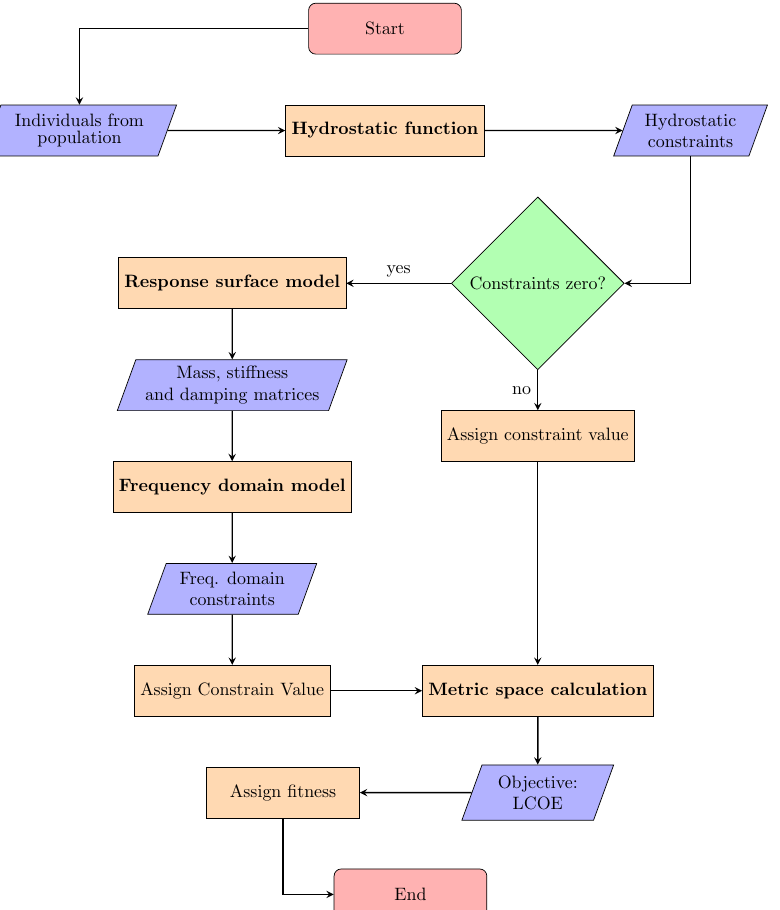
Figure 5. Flowchart of one iteration of the